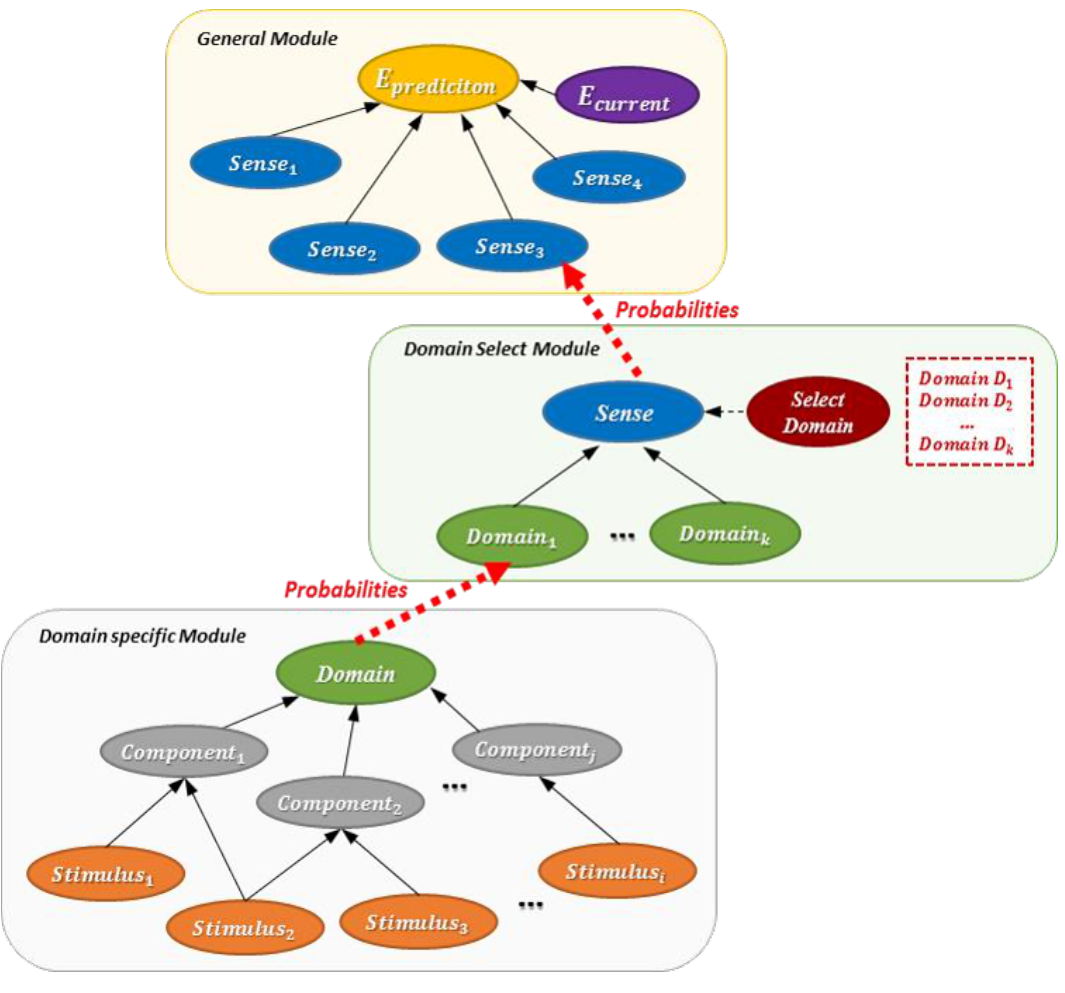
Figure 10. Emotion prediction model.